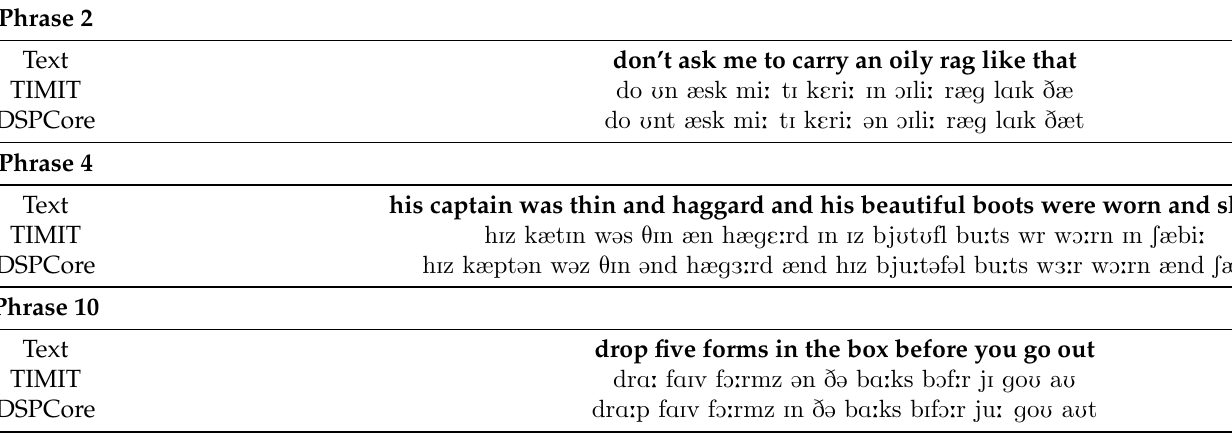
Table 2. Transcription